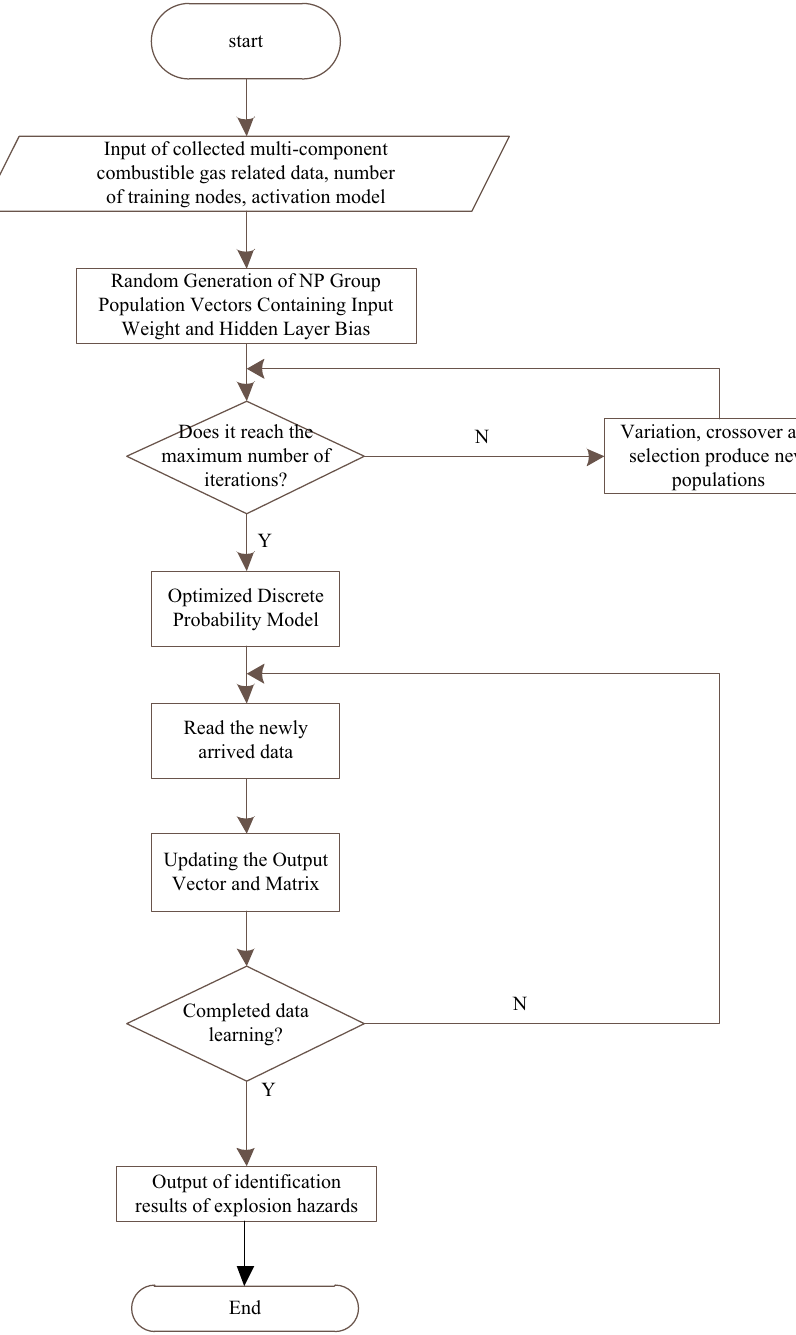
Figure 9: Flow chart for identifying multicomponent fl ammable gas explosion hazards based on discrete probability